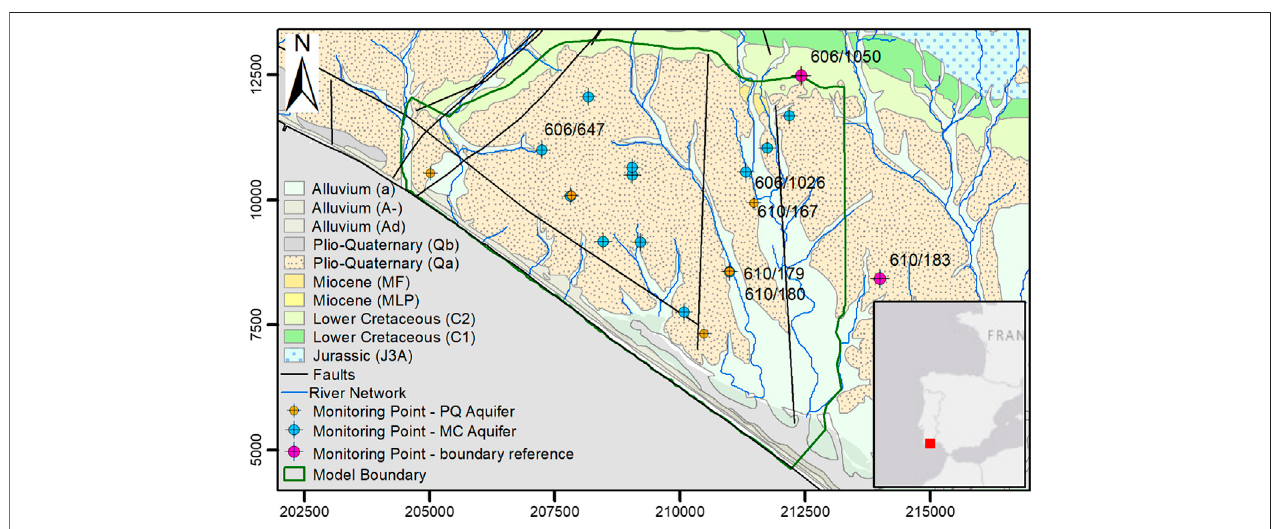
FIGURE 1 | Location and main hydrogeological features of the Vale do Lobo aquifer system, including piezometer locations.